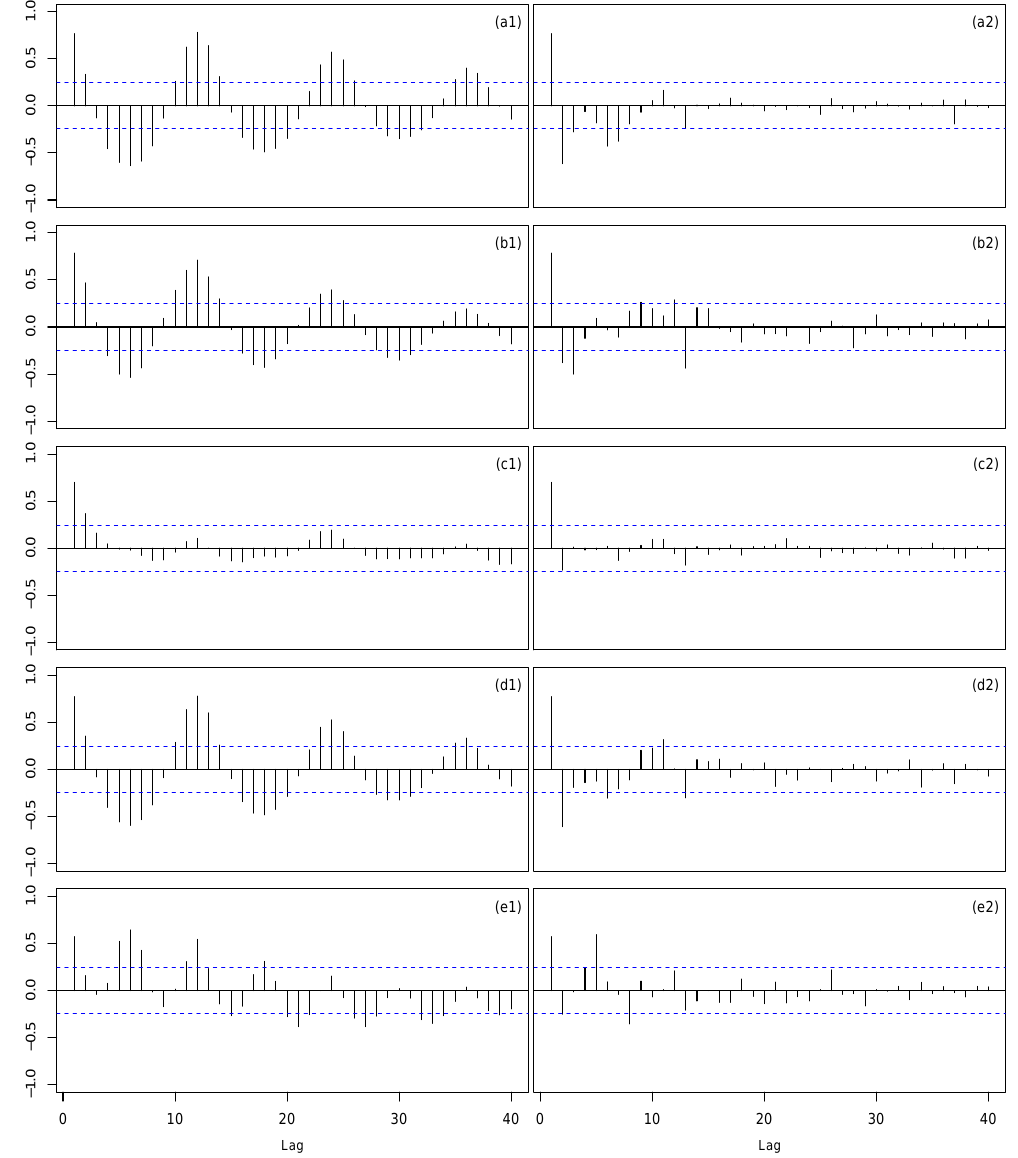
Figure 2. Sample autocorrelation function ( left panels) and sample partial autocorrelation function ( right panels) plots for the five footwear categories: Boots ( a1 , a2 ); Booties ( b1 , b2 ); Flats ( c1 , c2 ); Sandals ( d1 , d2 ); and Shoes ( e1 , e2